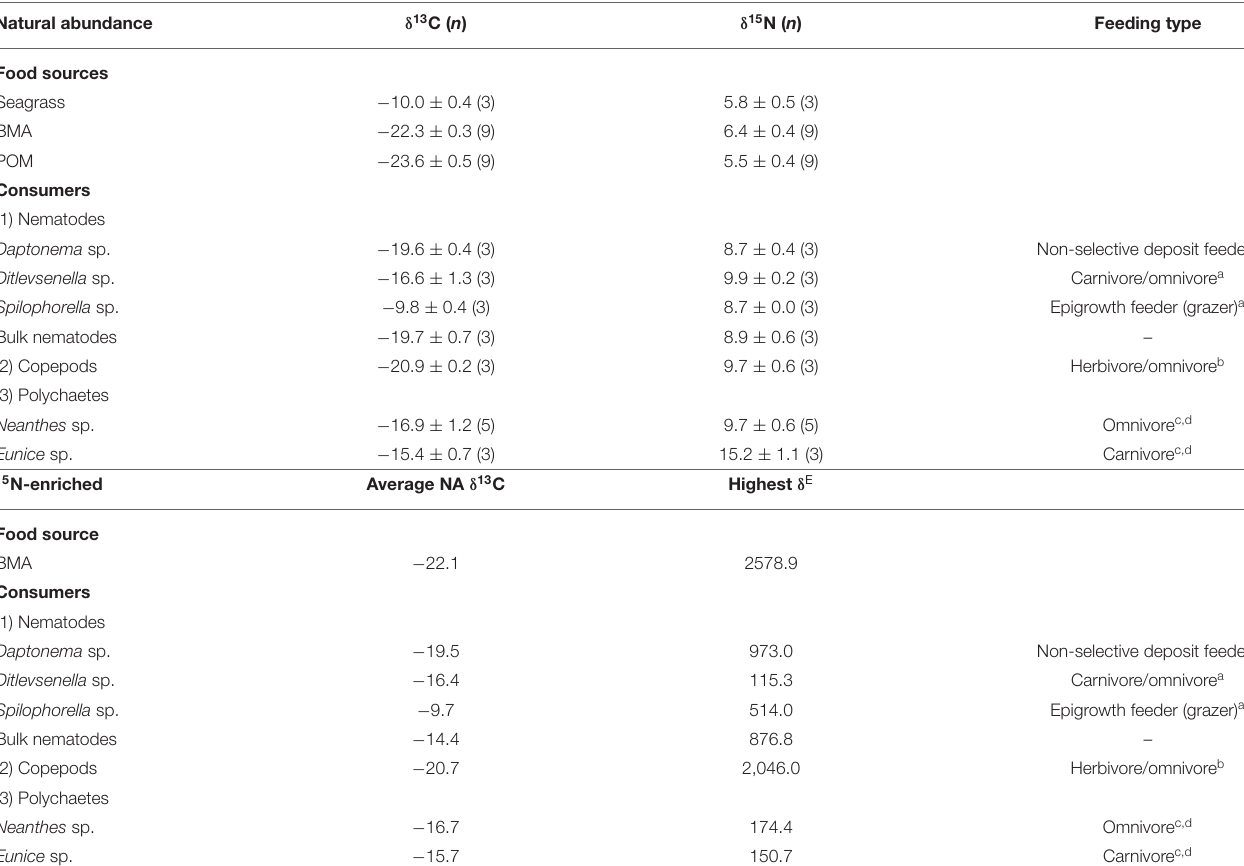
TABLE 1 | Natural abundance stable isotope δ 13 C and δ 15 N values of primary producers and infauna (data from Xu et al., 2018), and δ E (highest observed enrichment values minus natural abundance isotope values) over the 21-day experiment and average natural abundance (NA) δ 13 C values from the 21-day experiment. Natural abundance δ 13 C ( n ) δ 15 N ( n ) Feeding type Food